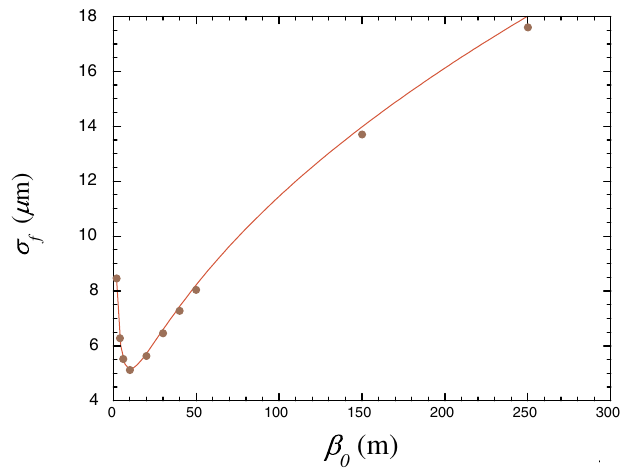
FIG. 12. (Color) Study of chromatic aberration effects in PLEIADES PMQ final-focus system, using ELEGANT simulation (dots), with theoretical prediction (line).